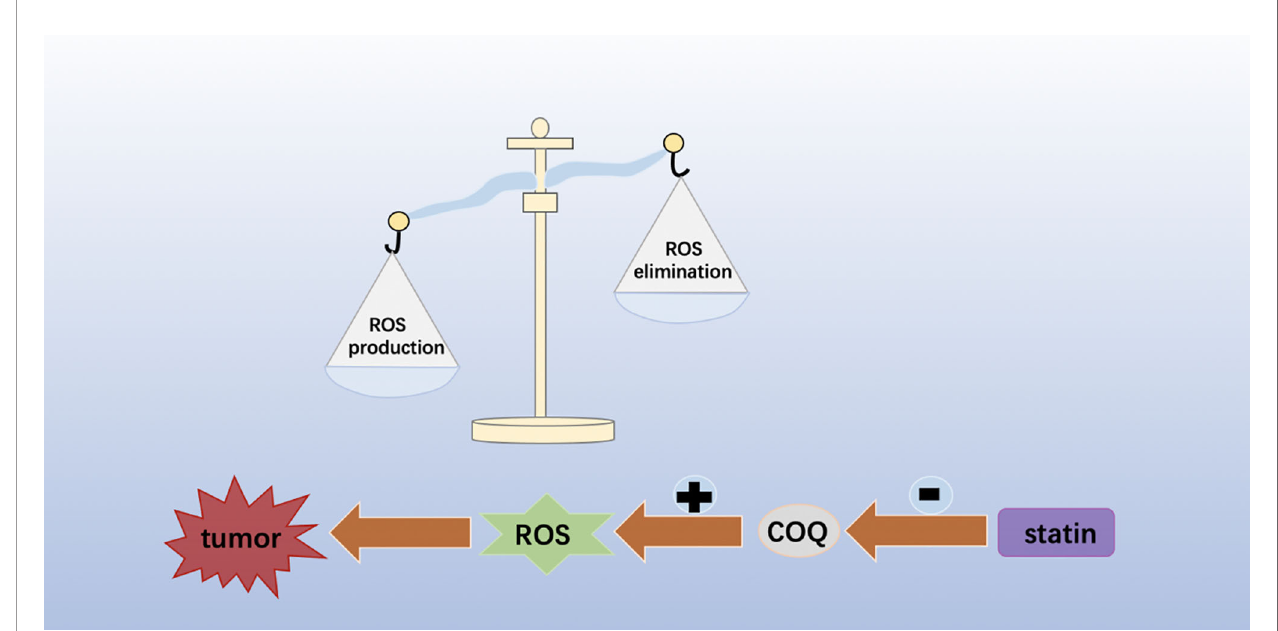
FIGURE 3 | Statins can mediate the loss of COQ and lead to severe oxidative stress, resulting in signi fi cant ROS production, which helps to improve the ef fi cacy of chemotherapy and shows anti-tumor